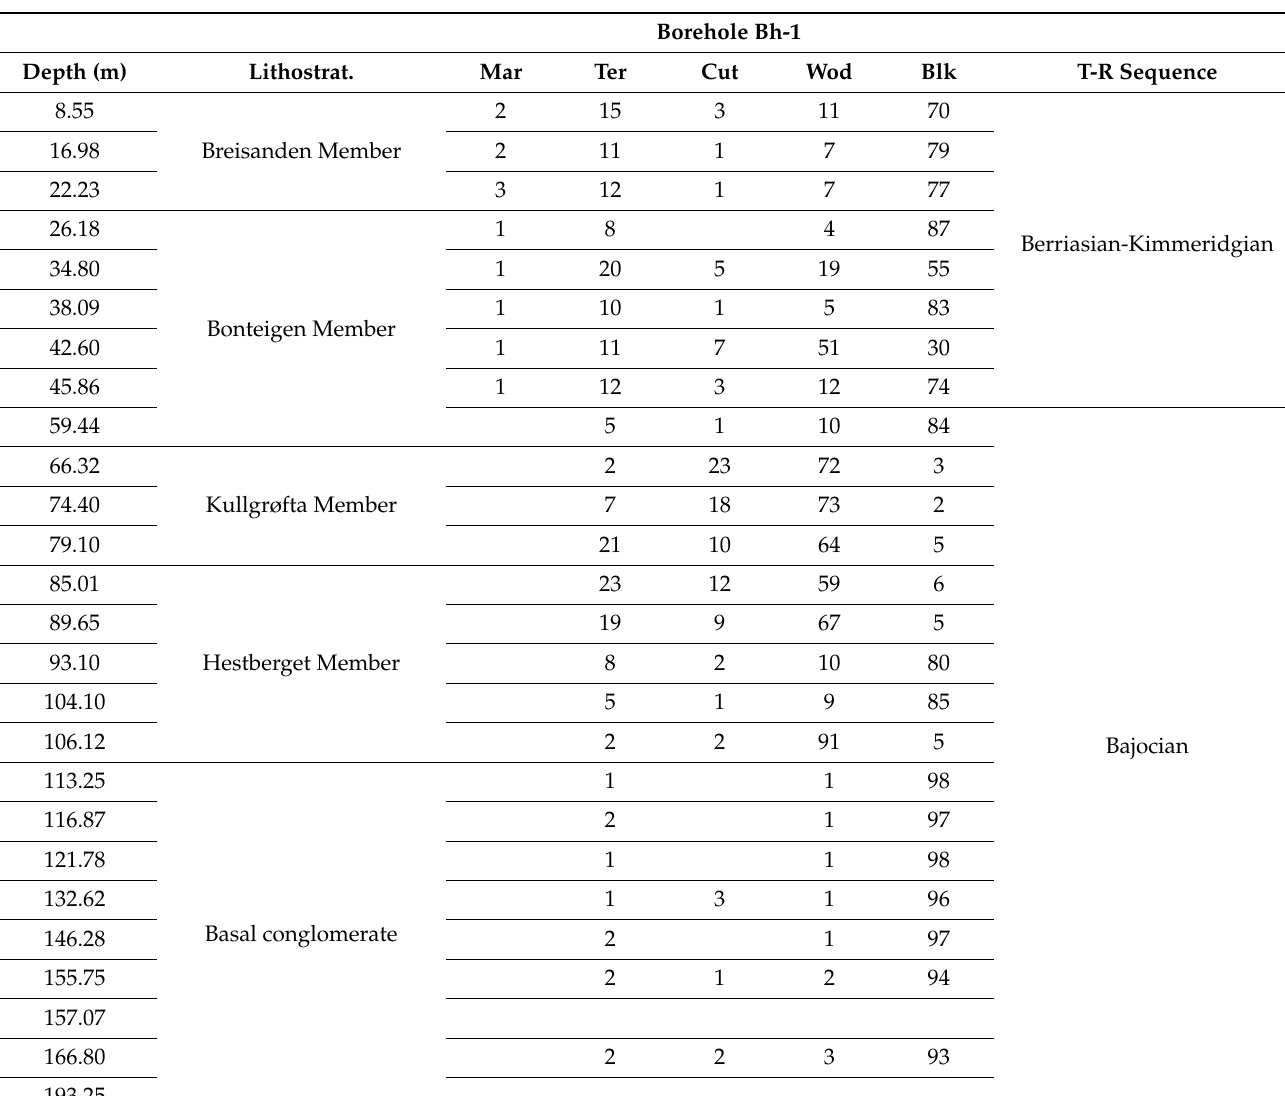
Table 1. Percentage distribution of particulate organic matter (POM) in Borehole Bh 1. Samples 157.07 m and 193.25 m were barren. Mar = marine palynomorphs (acritarchs, dinoflagellate cysts, prasinophycean algae); Ter = terrestrial palynomorphs (pollen, spores); Cut = cuticule, Wod = Woody fragments; Blk = black, coaly fragments